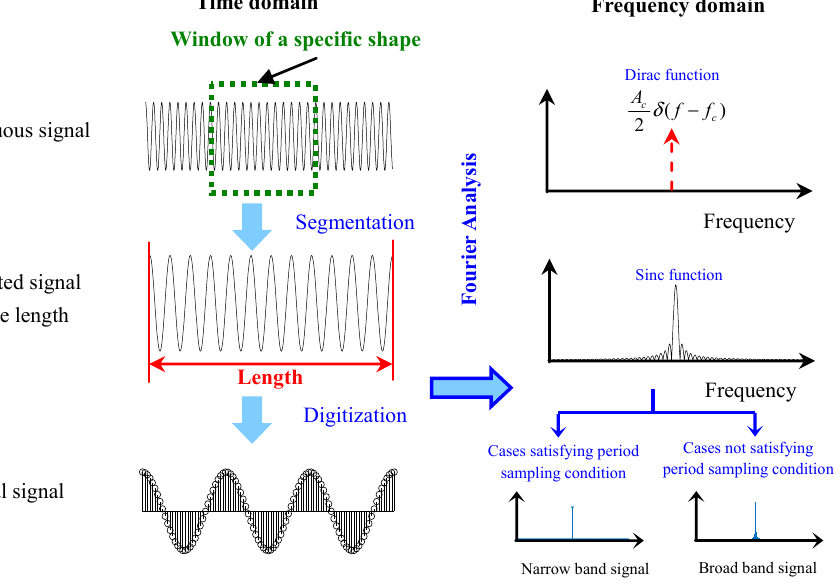
Figure 1. Collection of digital signals and its spectral analysis.